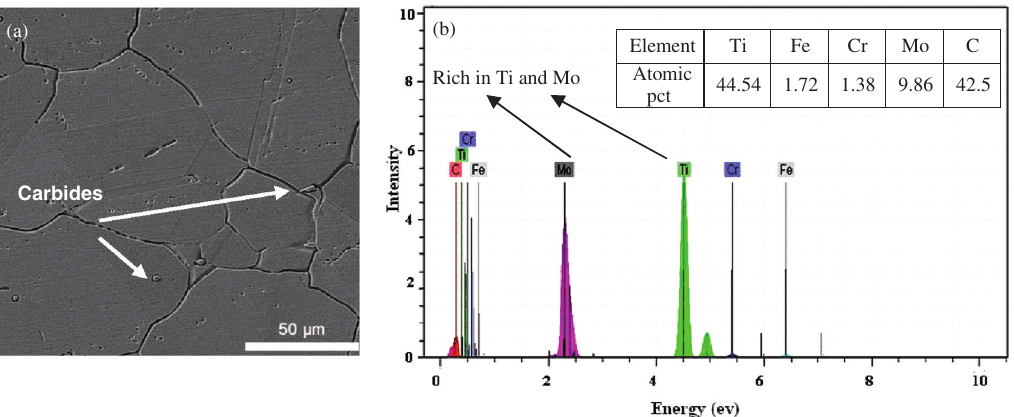
Figure 1: (a) SEM micrograph of as-heat-treated microstructure of Incoloy 901 superalloy containing 0.02 wt% carbon and (b) SEM-EDS spectra from particle 1.